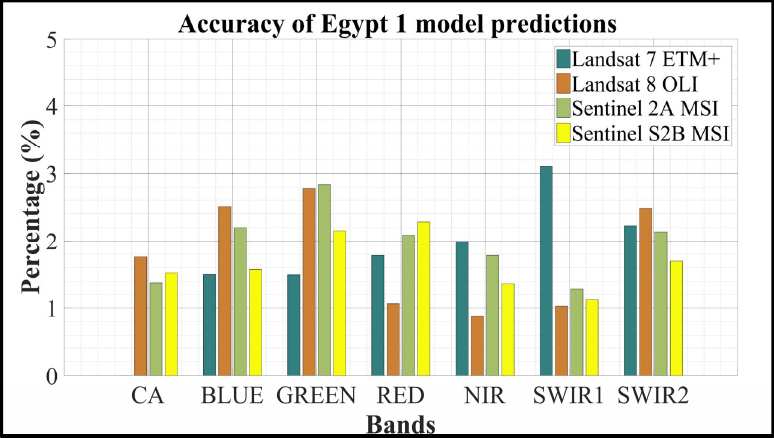
Figure 16. Percentage Difference between S2B MSI measurements and model predictions.